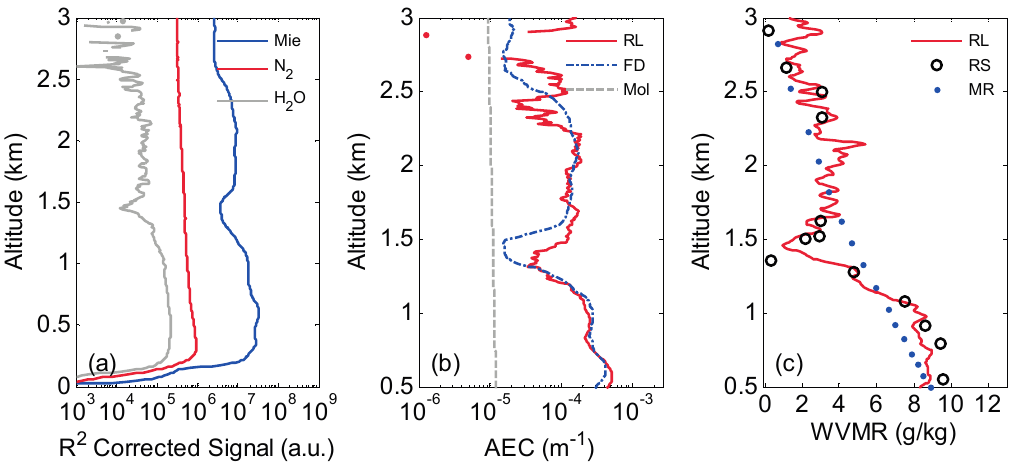
Figure 3. ( a ) Range-corrected signals of Mie, N 2 -Raman, and H 2 O-Raman measured at 8:00 p.m. to 8:30 p.m. Beijing time (CST) on 10 September 2013; ( b ) Aerosol extinction coefficient (AEC) retrieved through the Raman method (refer to RL with red solid line) and Fernald method (refer to FD with blue point dotted line), Mol with gray dotted line refer to molecule extinction coefficient; ( c ) Water vapor mixing ratio (WVMR) measured by Raman Lidar (RL) , RadioSonde (RS) and Microwave Radiometer (MR), which refer to the red solid line, black circle, and blue point,